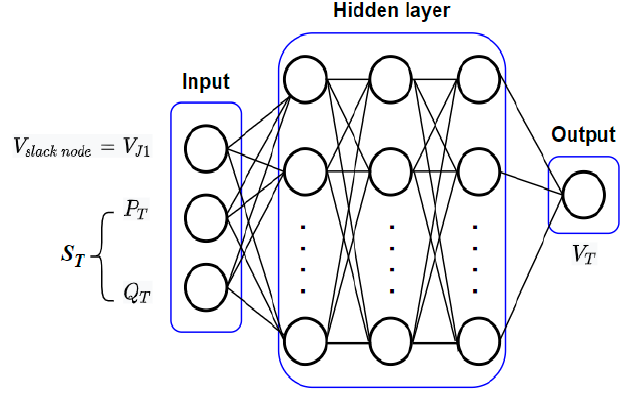
Figure 3 . High-Voltage Machine Learning Model . Figure 3. High-Voltage Machine Learning Model. Table 1. Number of neurons for each layer in the structure of HV-ML. ML Layer No. of Neurons Input 3 Hidden 1